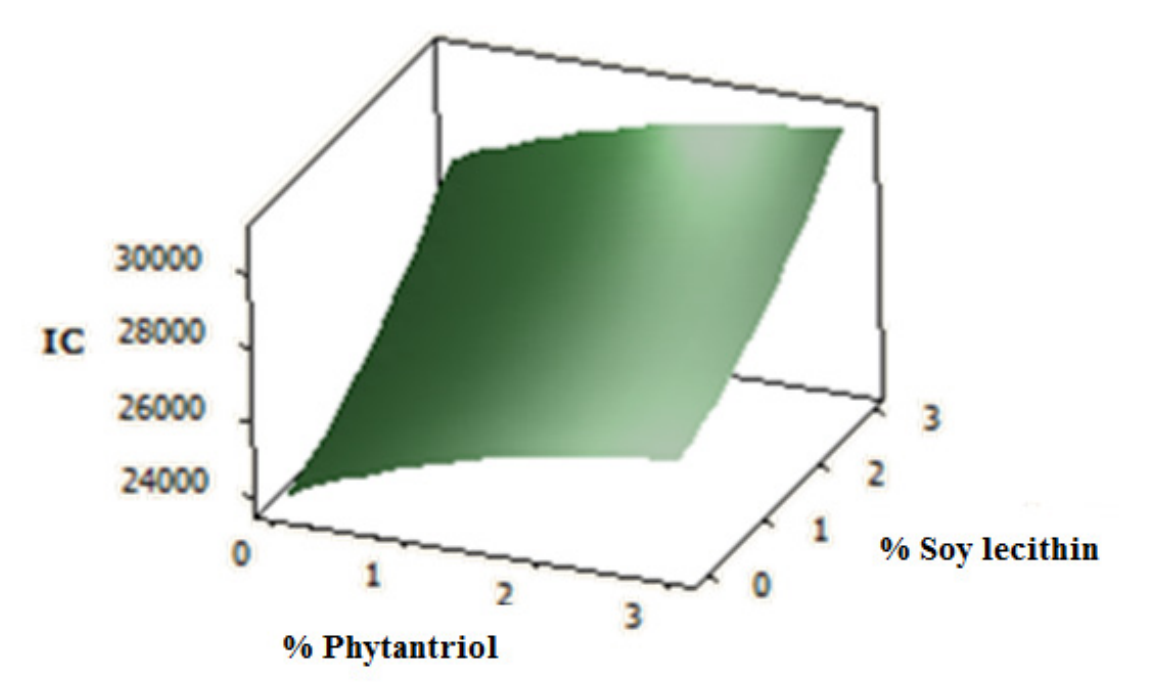
FIGURE 6 - Response surfaces for consistency index (CI) as a function of the factors: % of phytantriol and % of soy lecithin.